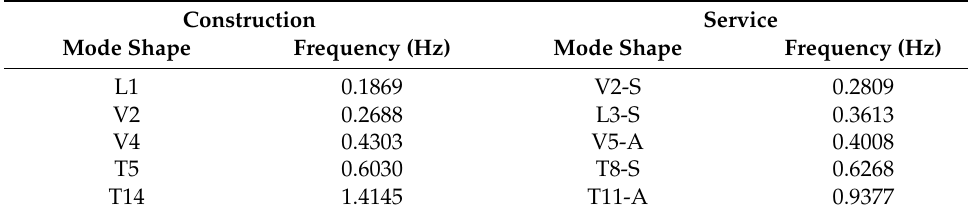
Table 2. Basic frequencies of construction and service